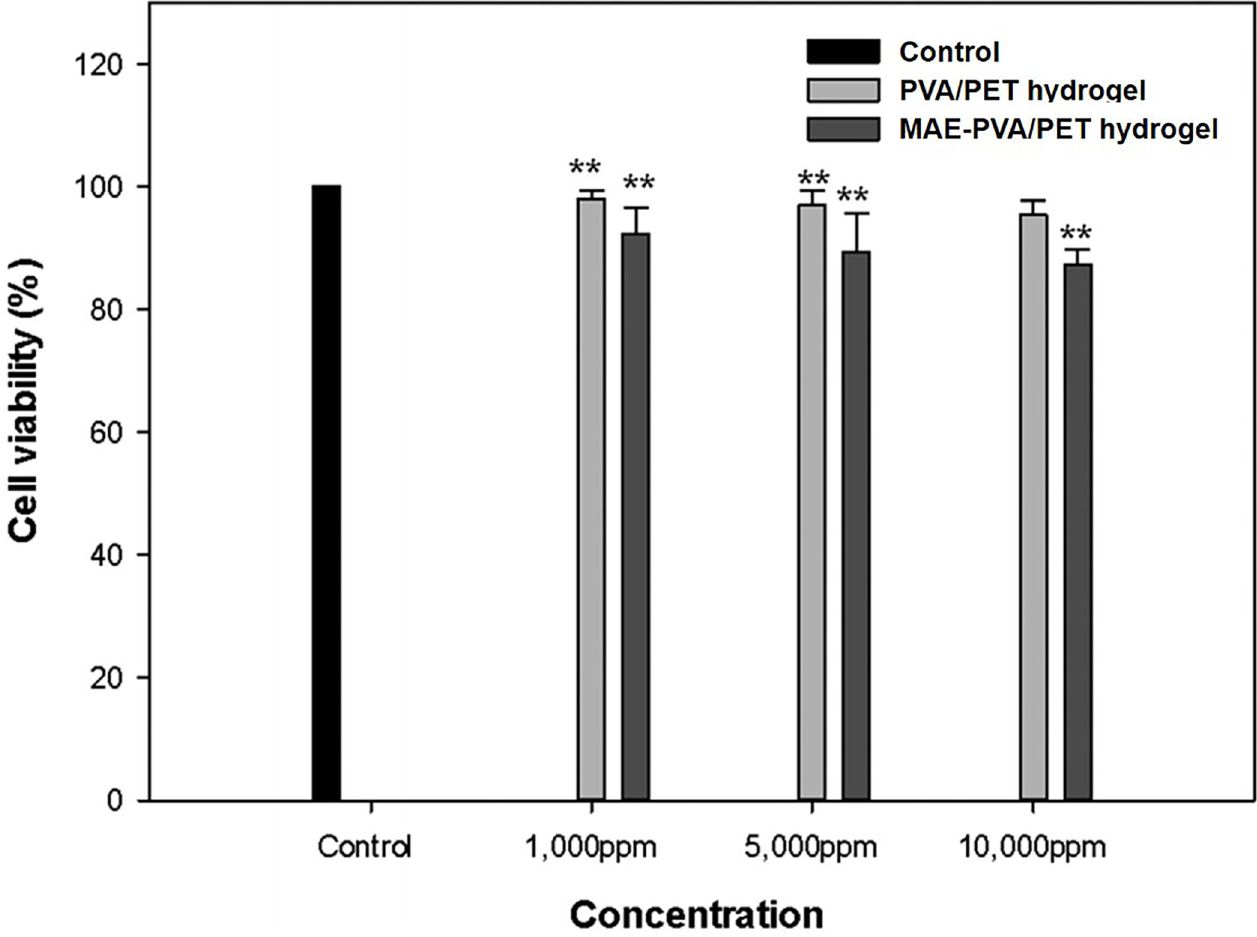
Fig 3. Cell viability assessment. Cell viability of RAW 264.7 cells treated with the extracts of the poly(vinyl alcohol)/pectin (PVA/PET) hydrogel and PVA/PET hydrogel containing Melia azedarach extract (MAE) nanoparticles. � p < 0.05 and �� p < 0.01 for comparisons between the control and experimental groups.